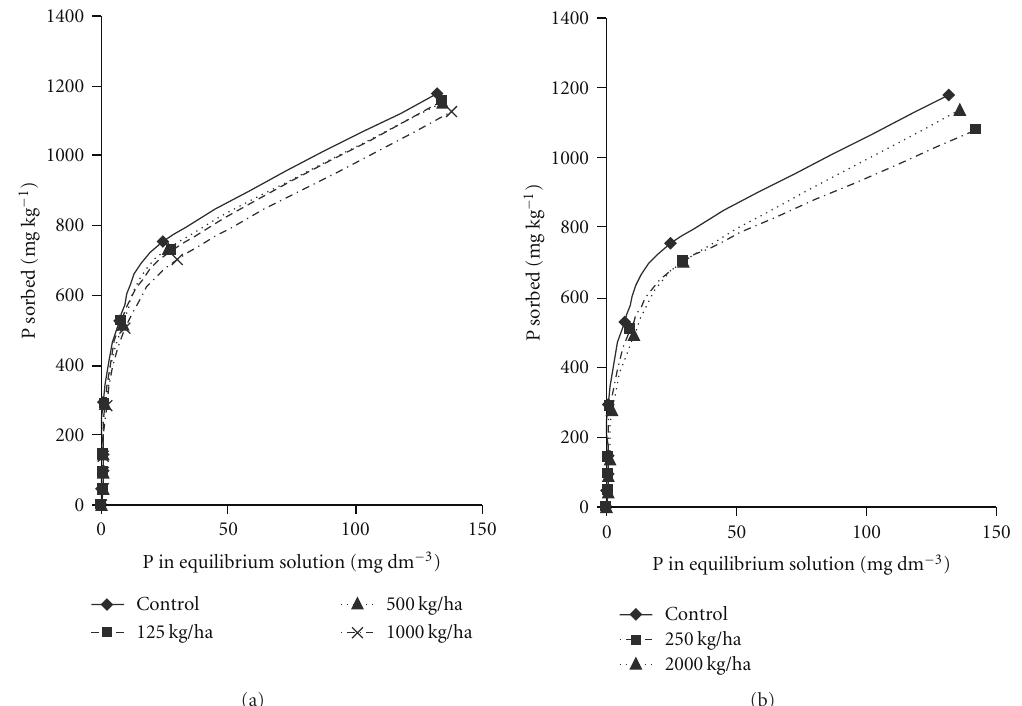
Figure 1: Phosphorussorption in aHaplorthox treated with increasingamountsof P applied through biosolidsaddition fromcities ofFranca (a) and Barueri (b).